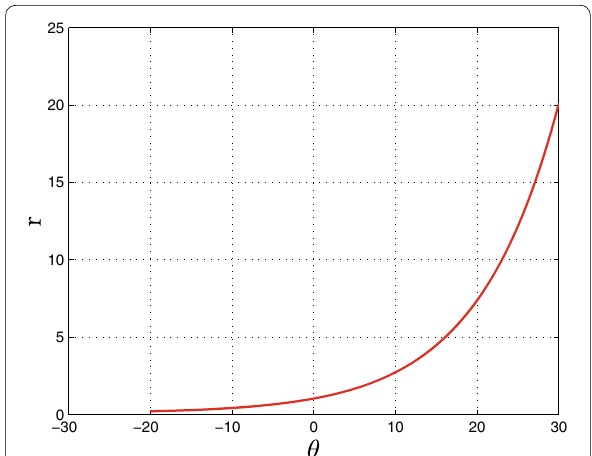
Figure 5 Error of the constrained system Eq.